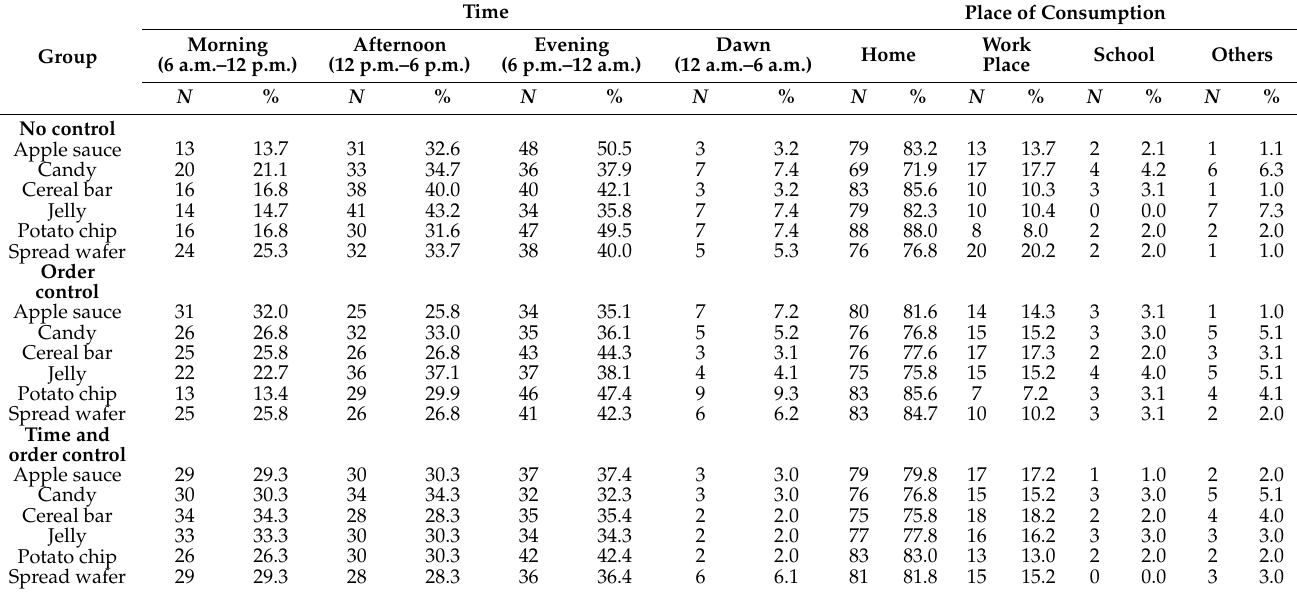
Table 4. Information of evaluation time and place for each consumer group 1